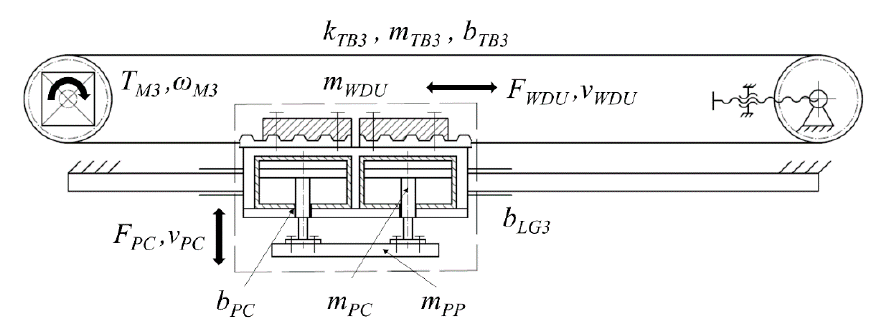
Figure 4. Schematic of the linear drive system of the work drive unit (WDU) [23].